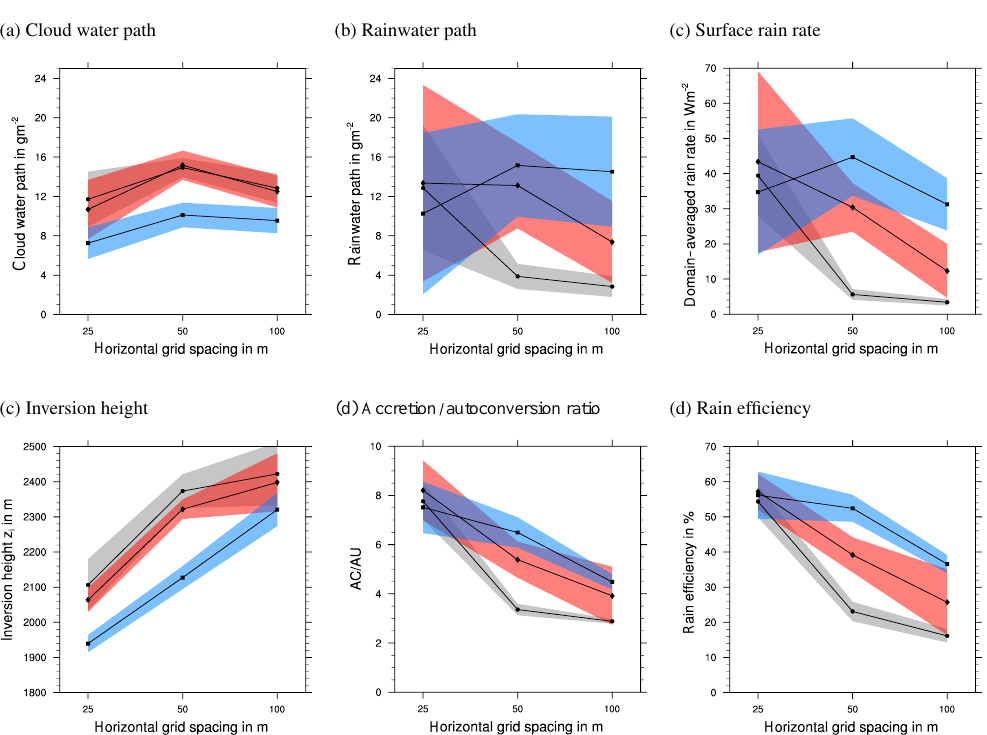
Figure 8. As Fig. 6 but showing the dependency of the results in the sampling period 24 to 30h on grid spacing for a cloud droplet number density of N c = 50cm − 3